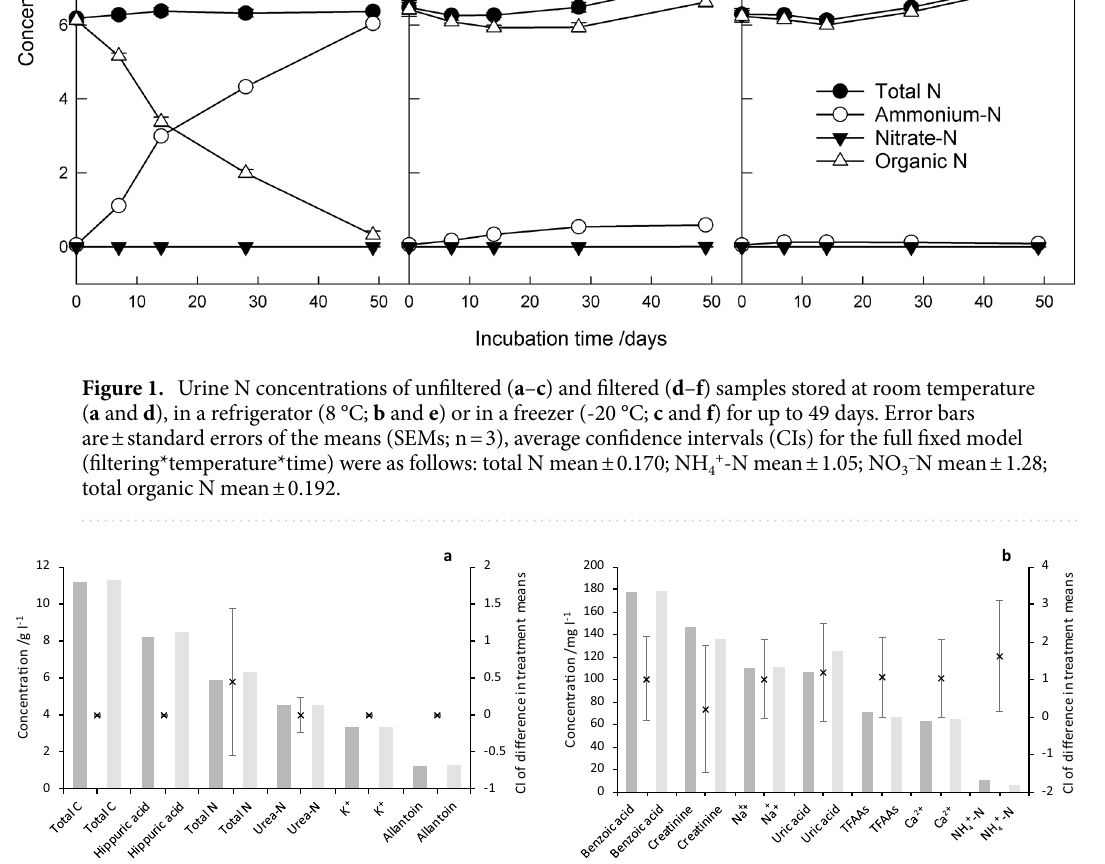
Figure 2. FD-1. Mean non-freeze-dried (darker bars; N) and freeze-dried (lighter bars; F) urine composition data: ( a ) Constituents with mean concentrations over 1 g l −1 , ( b ) Constituents with mean concentrations under 200 mg l −1 . Error bars show the CI of the difference between the treatment means (N vs. F; n = 6) and are centred on the difference between the means. (Note that 0 mg NO 3– N l −1 was recorded in all samples and is not